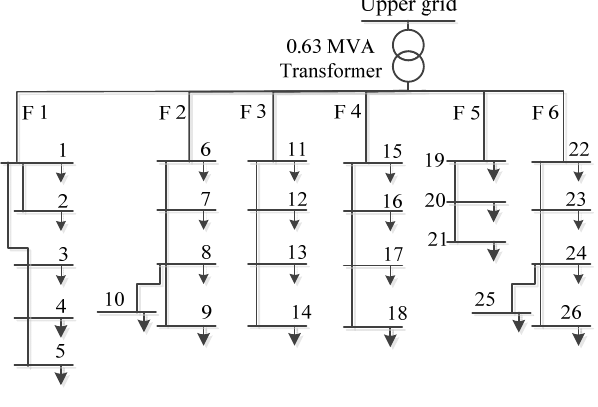
Figure 5. Overall view of the LV grid.